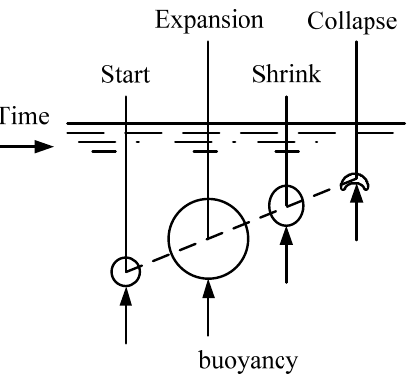
Figure 1. The pulsation process of cavitation bubbles affected by buoyancy.